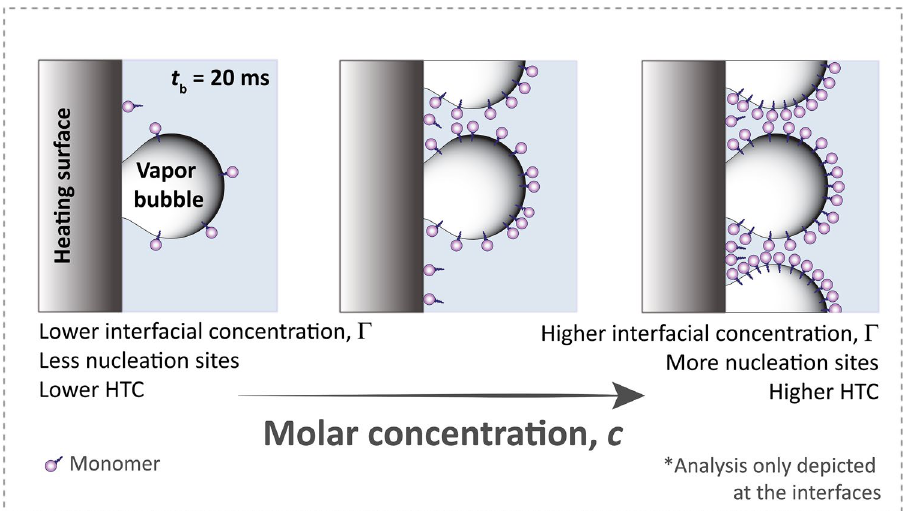
Figure 5. Dynamic adsorption of surfactants to the interfaces (solid–liquid and liquid–vapor) is responsible for HTC enhancement. With higher interfacial concentration, Ŵ , more bubble nucleation sites activate, resulting in higher